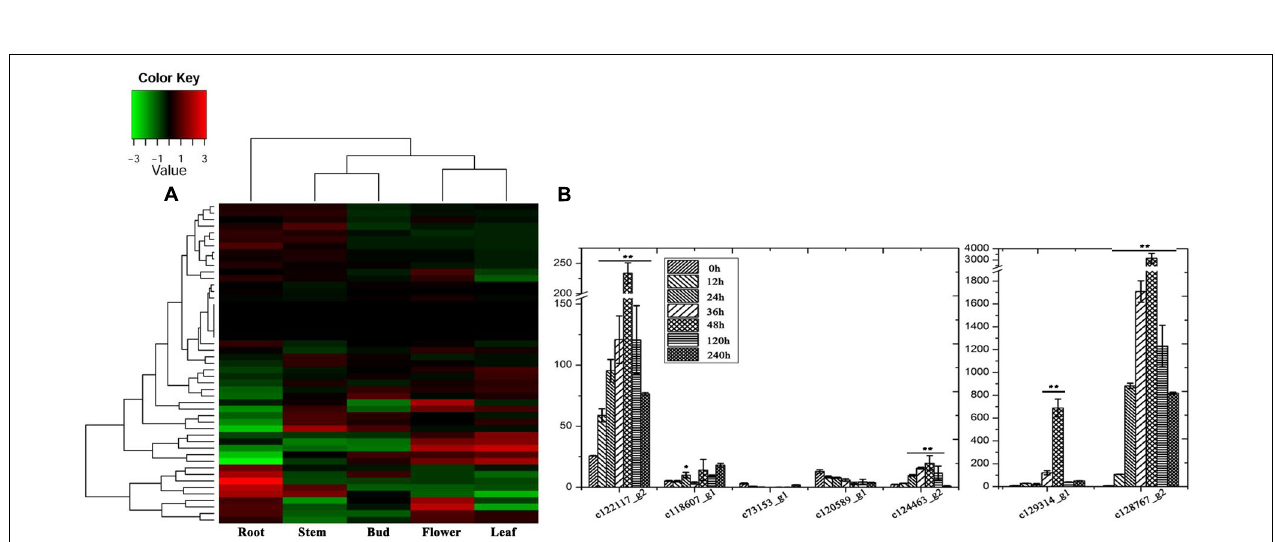
FIGURE 4 | Expression analysis of the glycosyltransferase genes. (A) Organ-specific expression analysis of the glycosyltransferase genes in D. nipponica . (B) Expression analysis of the glycosyltransferase genes highly expressed in roots in of MeJA-treated organs. Error bars are SD. Statistical significance was determined by Student’s t -test ( ∗ p ≤ 0.01; ∗∗ p ≤ 0.001).